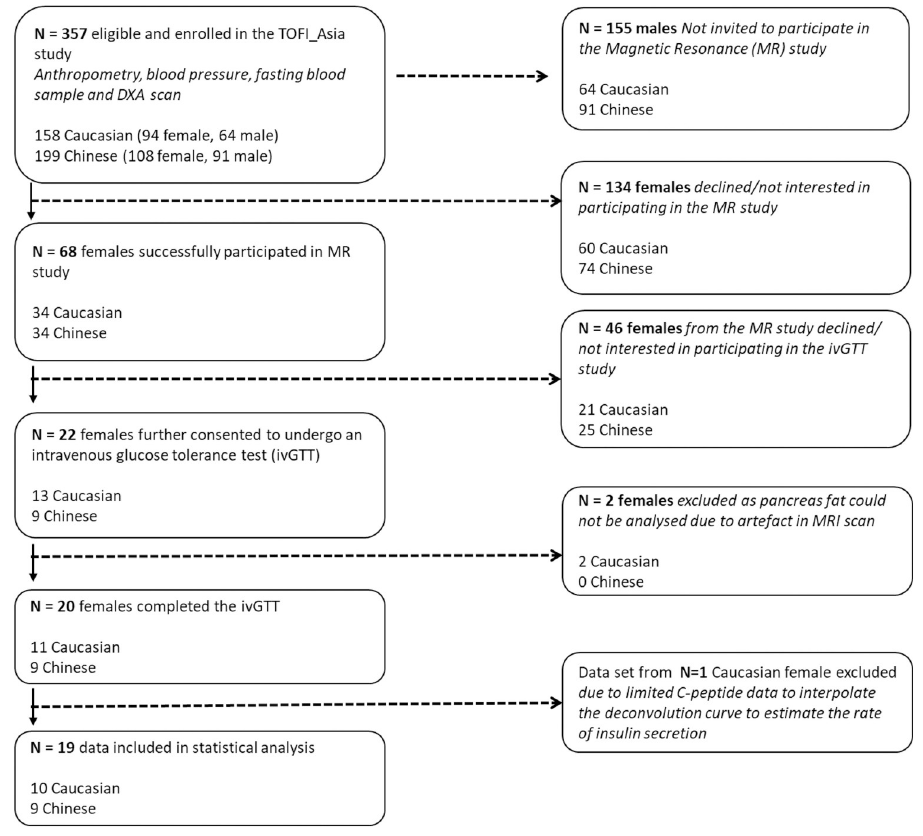
Fig 1. Flow chart illustrating enrolment and eligibility of female participants from the TOFI_Asia study for the ivGTT study. Nonstandard abbreviations : DXA, dual-energy X-ray absorptiometry; MR, magnetic